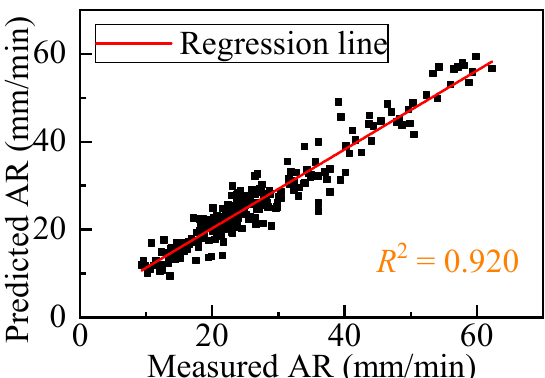
Figure 11. Predicted and actual AR values by the BPNN model for the test datasets.